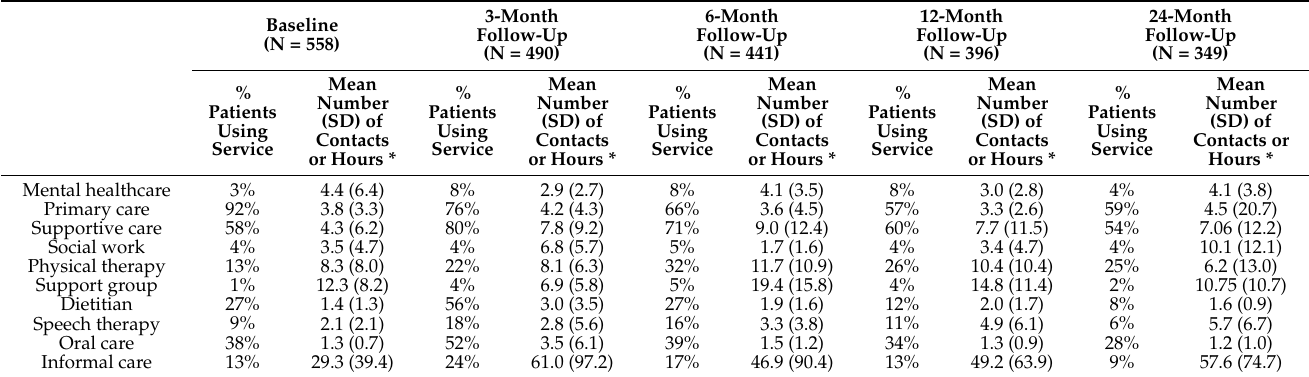
Table 2. Use of care at baseline, 3-, 6-, 12-, and 24-month